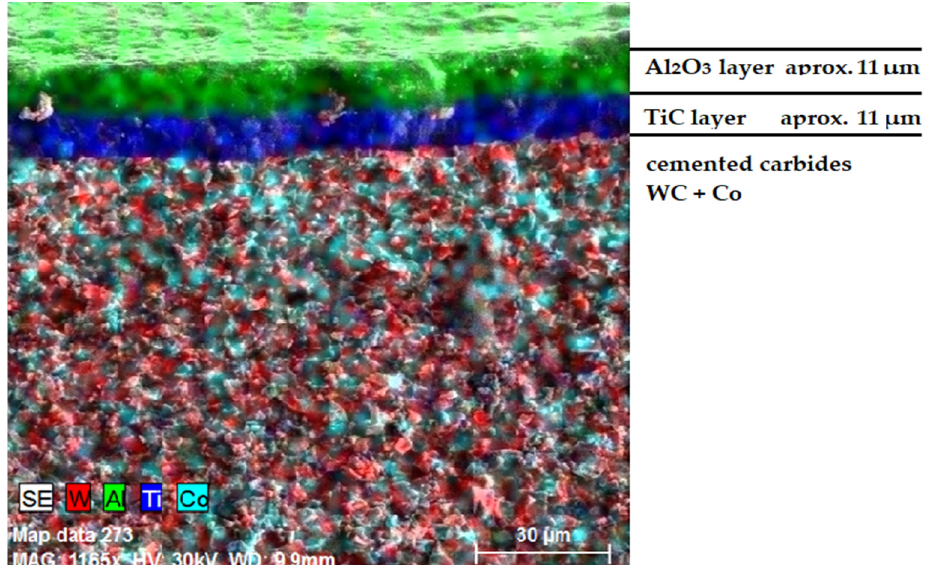
Figure 3. Coating thickness of CNMG 120408E-M GRADE T9315 carbide cutting insert.